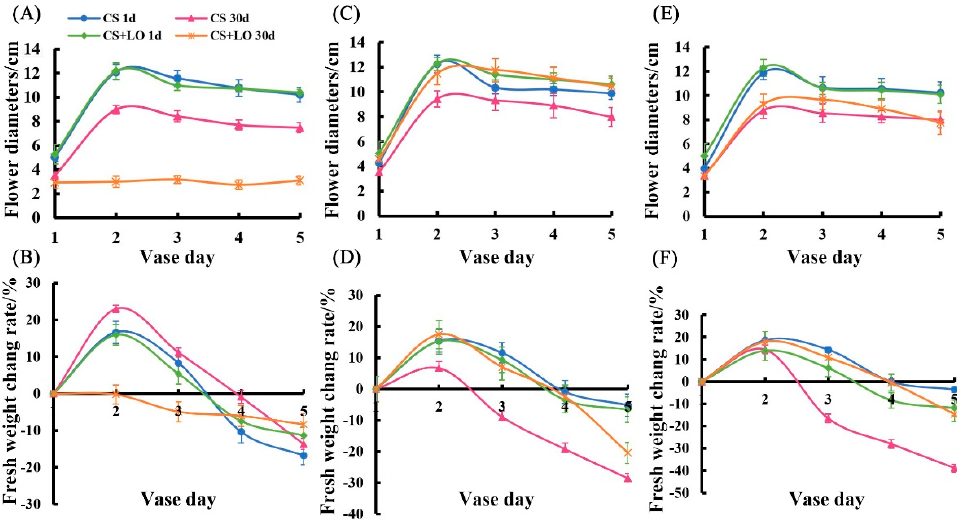
Figure 5. Flower diameter and the change rates of fresh weight of cut P. lactiflora in the vase after pre-treating and storage. ( A , B ) Flower diameter change and fresh weight change rate of cut flowers without pre-treatment during vase insertion on day 1 and day 30. ( C , D ) Flower diameter change and fresh weight change rate of cut flowers pre-treated by 8-HQ during vase insertion on day 1 and day 30. ( E , F ) Flower diameter change and fresh weight change rate of cut flowers pre-treated by NS during vase insertion on day 1 and day 30. CS, Cold storage; CS + LO, Cold storage + Low oxygen. Values are expressed as the mean ± SD of three analyses. The vertical bar represents the standard deviation of the mean.